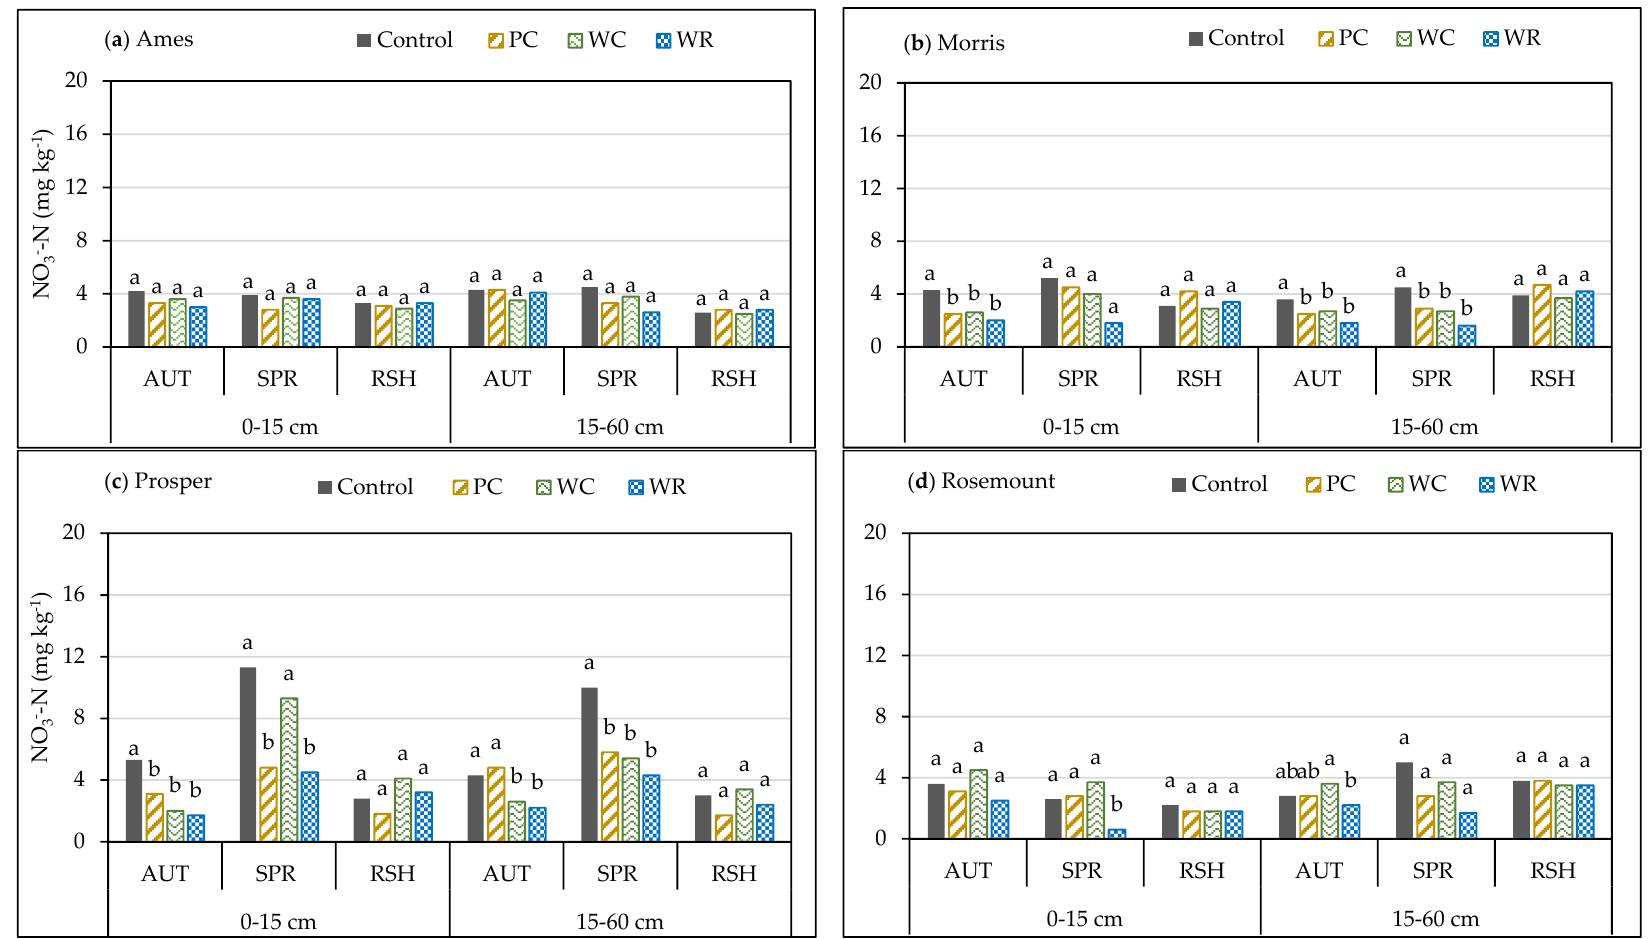
Figure 3. Mean soil NO 3 − -N (mg kg − 1 ) at 0–15 cm and 15–60 cm soil depths for control (no-cover crop), pennycress (PC), winter camelina (WC), and winter rye (WR) when cover crops were interseeded in standing soybean at ( a ) Ames, ( b ) Morris, ( c ) Prosper, and ( d ) Rosemount. AUT = soil samples taken in autumn; SPR = soil samples taken in spring; RSH = soil sample taken immediately following relayed soybean harvesting. Means with the same letter under same soil depth and same season at a location were statistically the